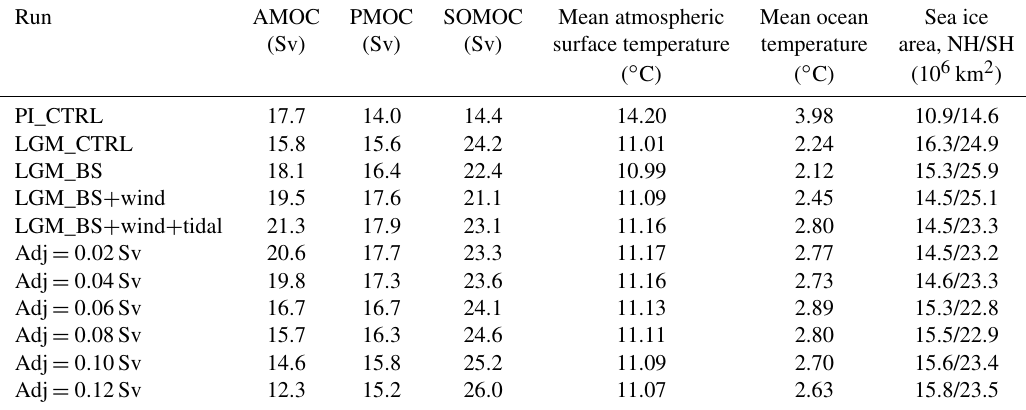
Adj = 0 . 08Sv Adj = 0 . 10Sv